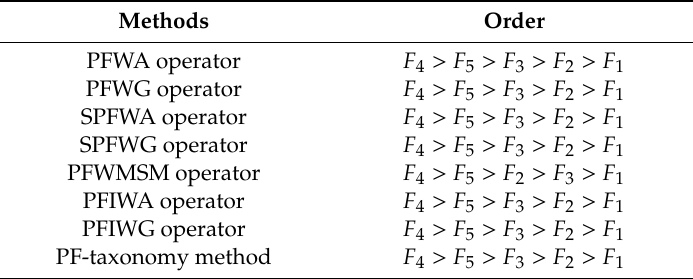
Table 14. Alternatives’ ranking by some existing